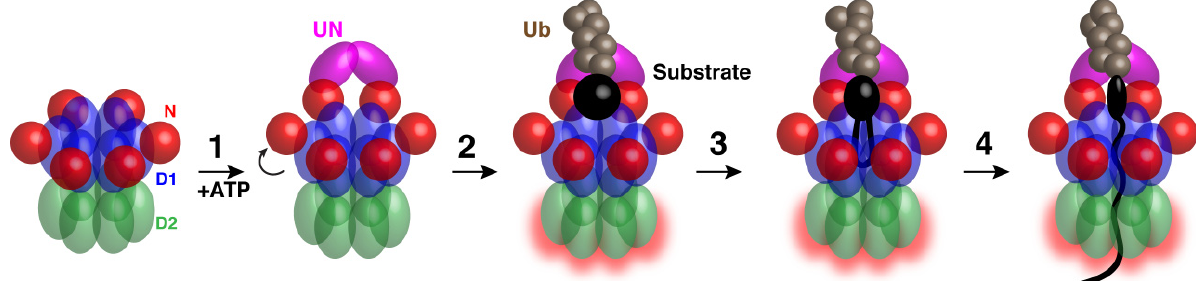
Figure 2. Model for Cdc48 substrate unfolding. The process begins with the N domains in the “down conformation”. In step 1, the N domains transition into the “up conformation” upon D1 ATP binding. Binding of the Ufd1/Npl4 (UN) complex to the N domains renders the complex competent for substrate binding. In step 2, the polyubiquitin chain attached to a substrate binds to the UN complex. The D1 domain stays in the ATP-bound state with the N domains in the “up conformation”. At the same time, the ATPase rate of the D2 domains is increased (red outline). In step 3, the substrate inserts into the central pore. In step 4, ATP hydrolysis by the D2 domains unfolds the substrate by pulling it through the pore to the trans